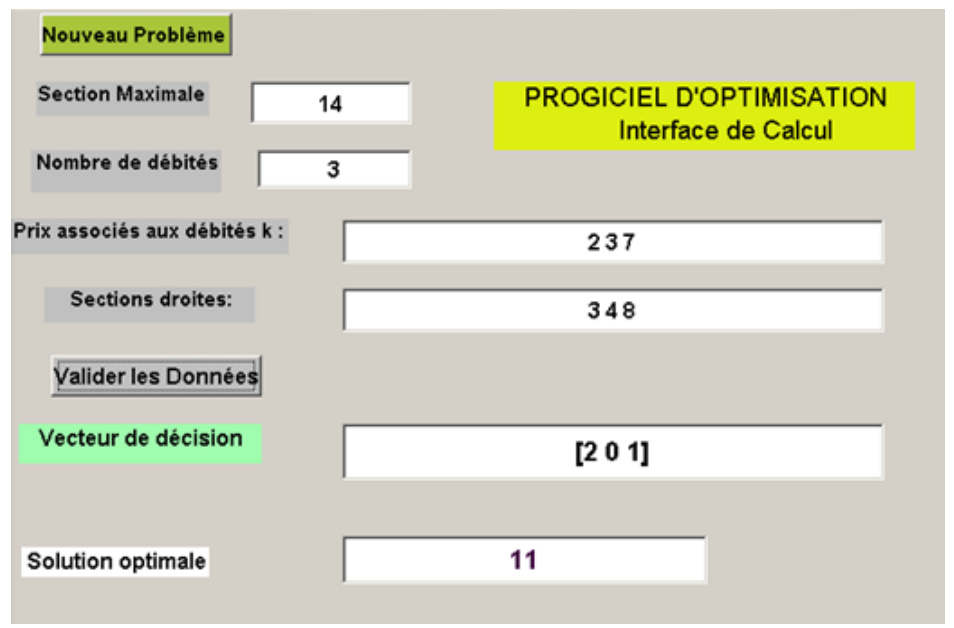
Figure 2. Optimisation software